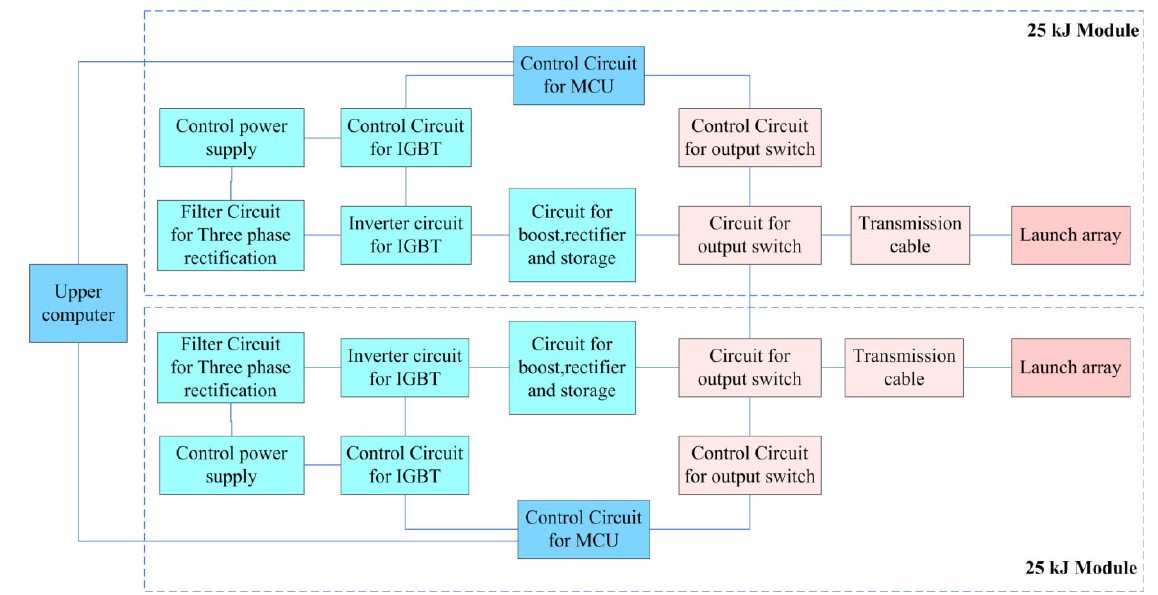
Figure 2. Structure diagram of the ultra ‐ high ‐ energy plasma source.